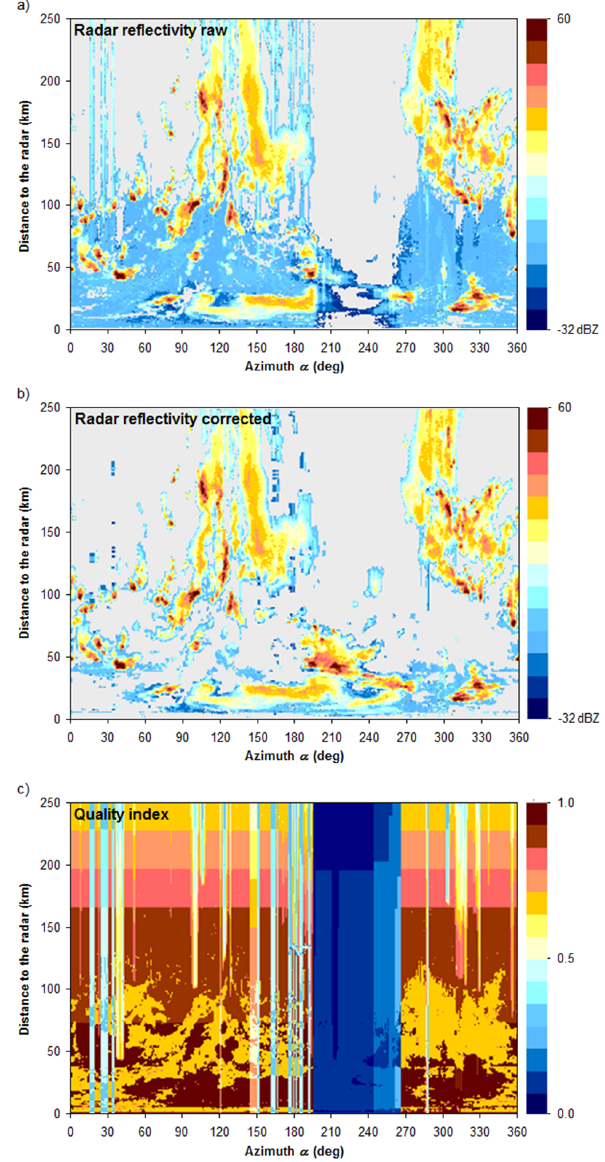
Figure 4. The lowest scan (0.5 ◦ ) in volume from Brzuchania radar, 27 May 2014, 14:30UTC, in polar coordinates: (a) raw data, (b) corrected data, (c) quality